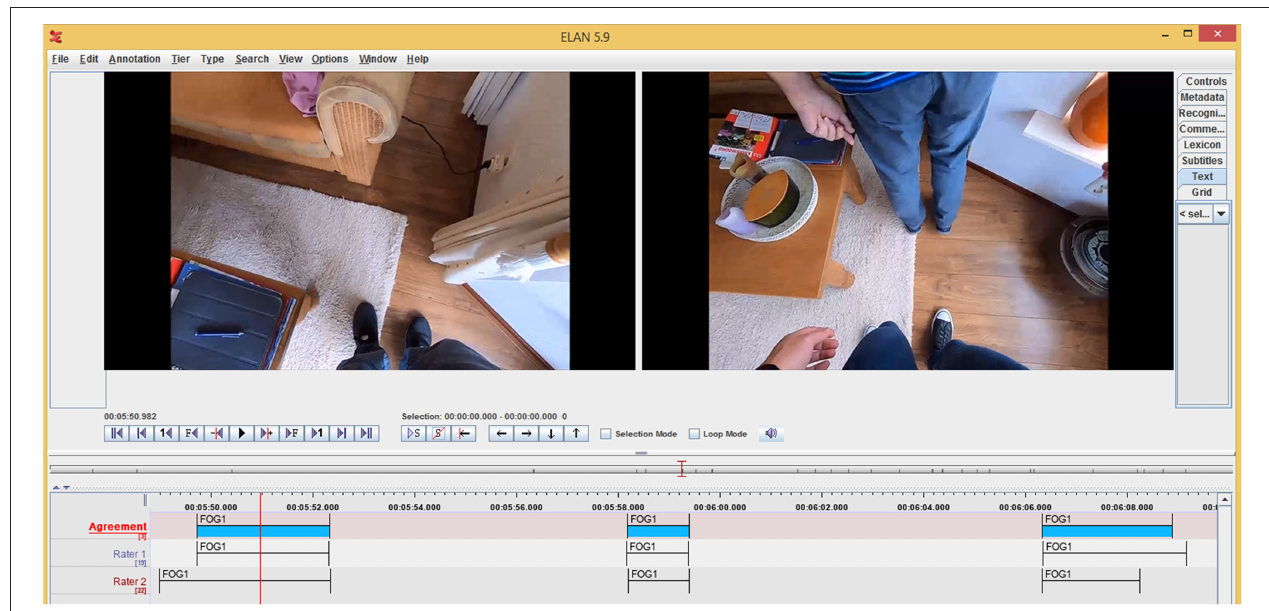
FIGURE 4 | Exemplary annotations of Raters 1 and 2 (bottom two tiers) in ELAN version 5.9 based on videos from GoPro cameras attached to the chest of the participant (left video still) and researcher (right video still). In the top tier, the final FOG annotations (blue patches) are shown after automatically combining annotations of Raters 1 and 2 for time points closer than 200ms apart the average of the two ratings was taken (cf. the starts and ends of the second FOG annotation in the depicted tiers) or after consensus was reached by discussing time points further than 200ms apart (cf. time points to the far left and right in the